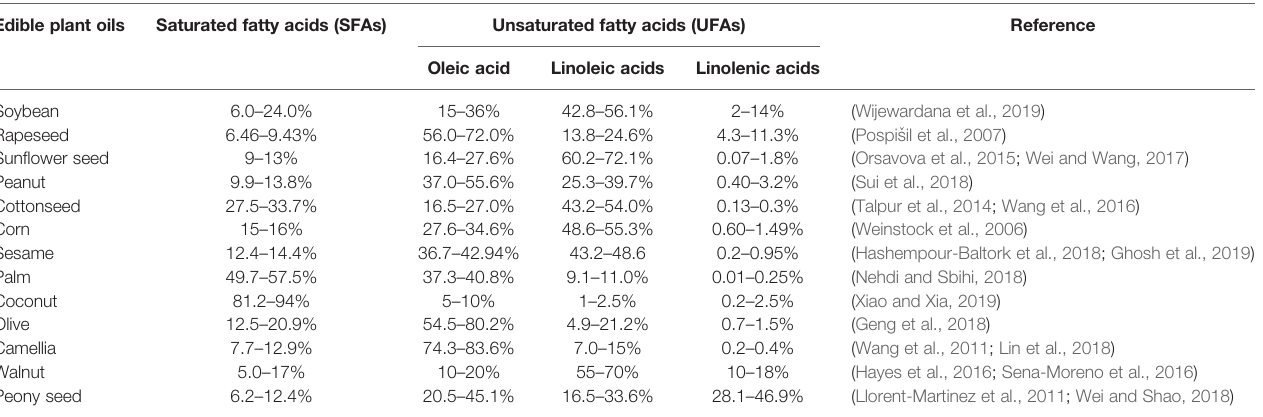
TABLE 4 | Fatty acid content (%) in some EPOs. Edible plant